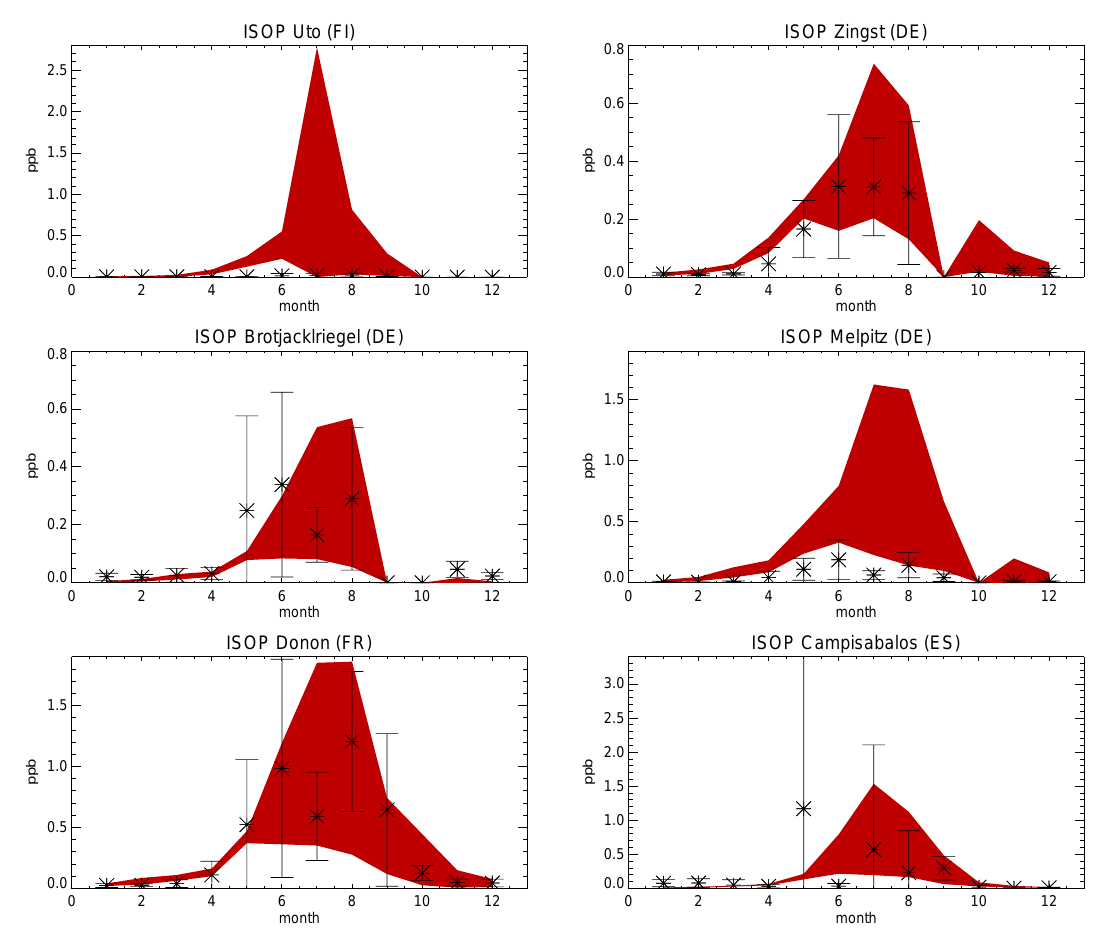
Fig. 7. The seasonal variability in isoprene across Europe as sampled at various EMEP monitoring stations during 2000. Comparisons are shown for single stations located at (from top to bottom) Ut¨o (Finland, 59.5 ◦ N, 21.1 ◦ E), Zingst (Germany, 54.4 ◦ N, 12.7 ◦ E), Brotjacklriegel (Germany, 48.5 ◦ N, 13.1 ◦ E) , Melpitz (Germany, 51.3 ◦ N, 12.5 ◦ E), Donon (France, 48.3 ◦ N, 7.8 ◦ E) and Campisabalos (Spain, 41.1 ◦ N, 3.8 ◦